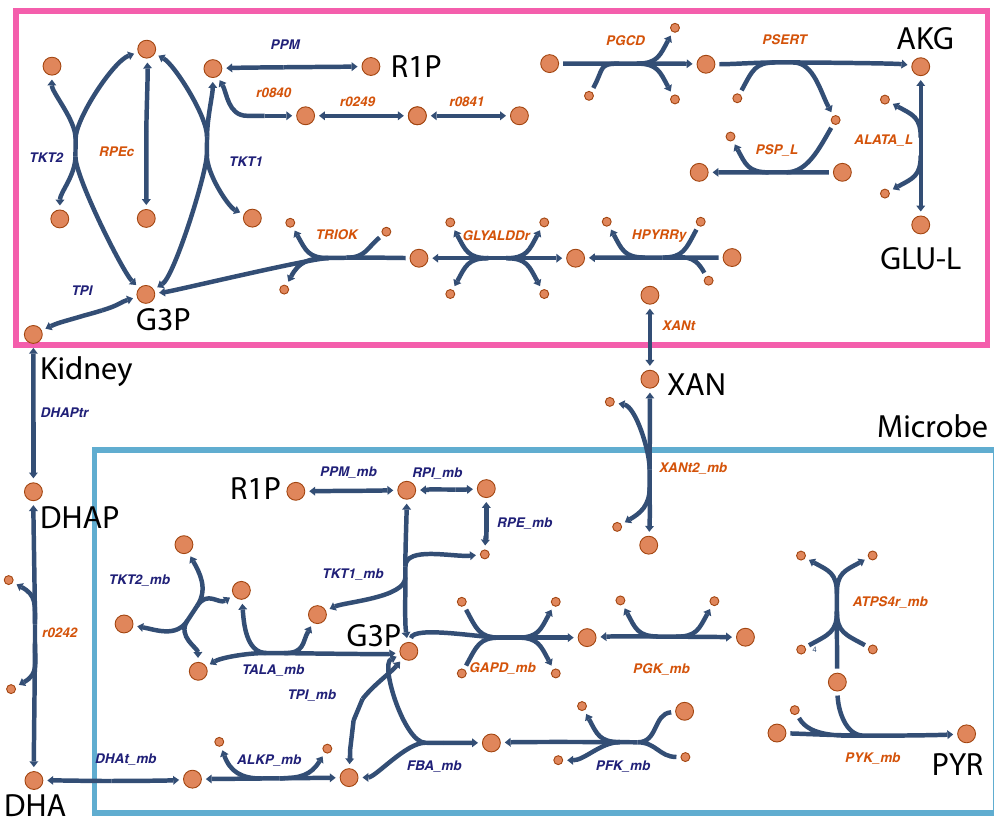
Figure 8. Kidney-microbiome interactions revealed by analysis of reaction co-sets connects host (kidney) and gut microbial metabolic pathways via transport. Reaction co-sets provide a means of identifying functionally correlated pathways by delineation of groups of reactions that are linked together based upon flux correlations 77 . The kidney-microbiome steady state flux space was interrogated in order to identify reaction co-sets involving the host as well as the microbiome, reflected as changes in the plasma metabolite concentrations. The illustrated central metabolic pathways centering around hexose and pentose sugar metabolism provide direct links between the host and microbiome. Links between glycolysis and the non-oxidative pentose phosphate pathway are directly coupled via inter-organismal (host-microbiome) transport of dihydroxyacetone phosphate and dihydroxyacetone. Other metabolites such as xanthine and L-alanine are present in some but not all of the co-sets for the four models (Oat1WT, Oat1KO, Oat3WT, Oat3KO), reflecting the condition/context dependence of the co-sets. Reactions with blue names are present in all four models (reactions with red names are present in one, two, or three models). Abbreviations are as follows, with those enzymes and transporters present in the microbiome as opposed to the host indicated as “x_mb (microbiome)”: ALATA_L l-alanine